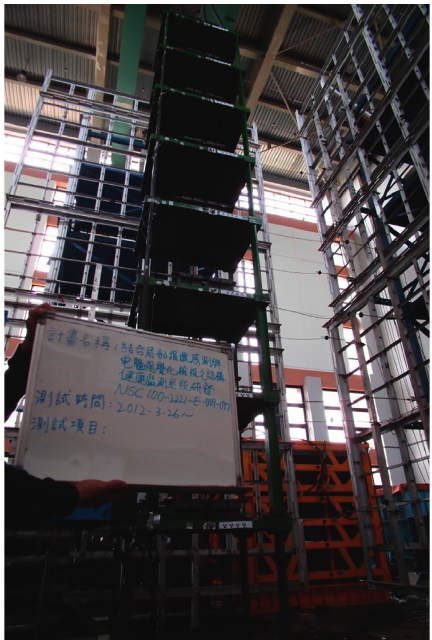
Figure 25: The eight-story steel frame.